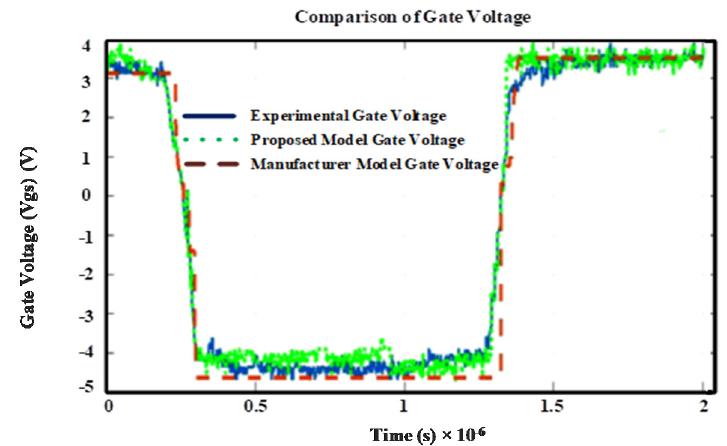
Figure 20. Comparison of switching voltage waveforms of models with DPT results.